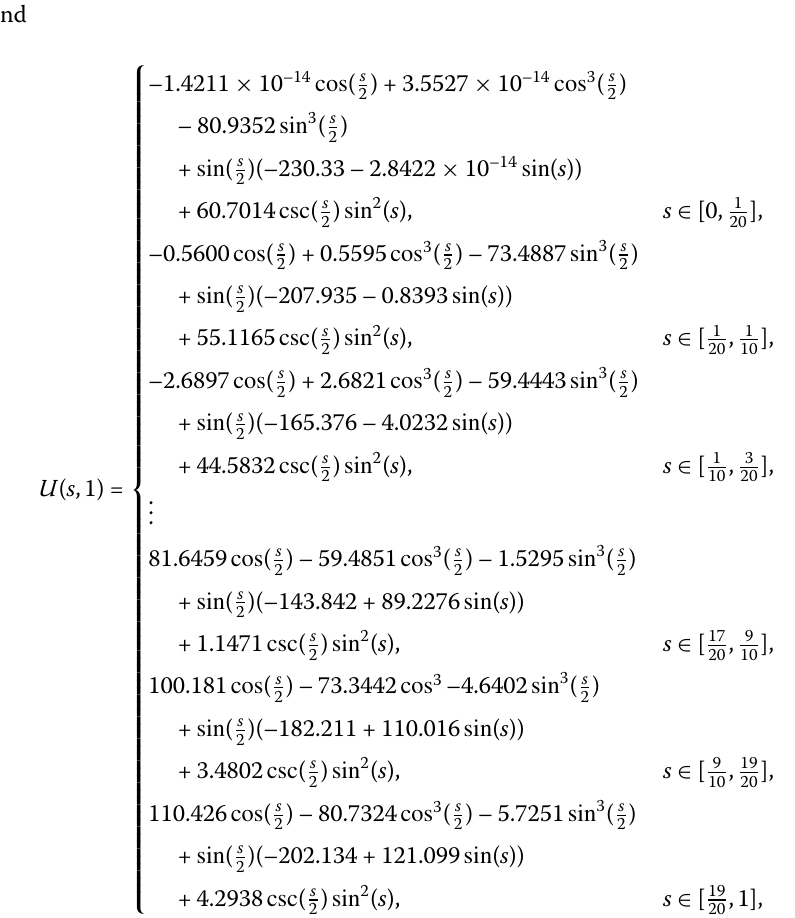
Figure 4 The exact (lines) and numerical (rectangles, stars, bullets) solutions when τ = 0.01, h = 1 time levels for Example